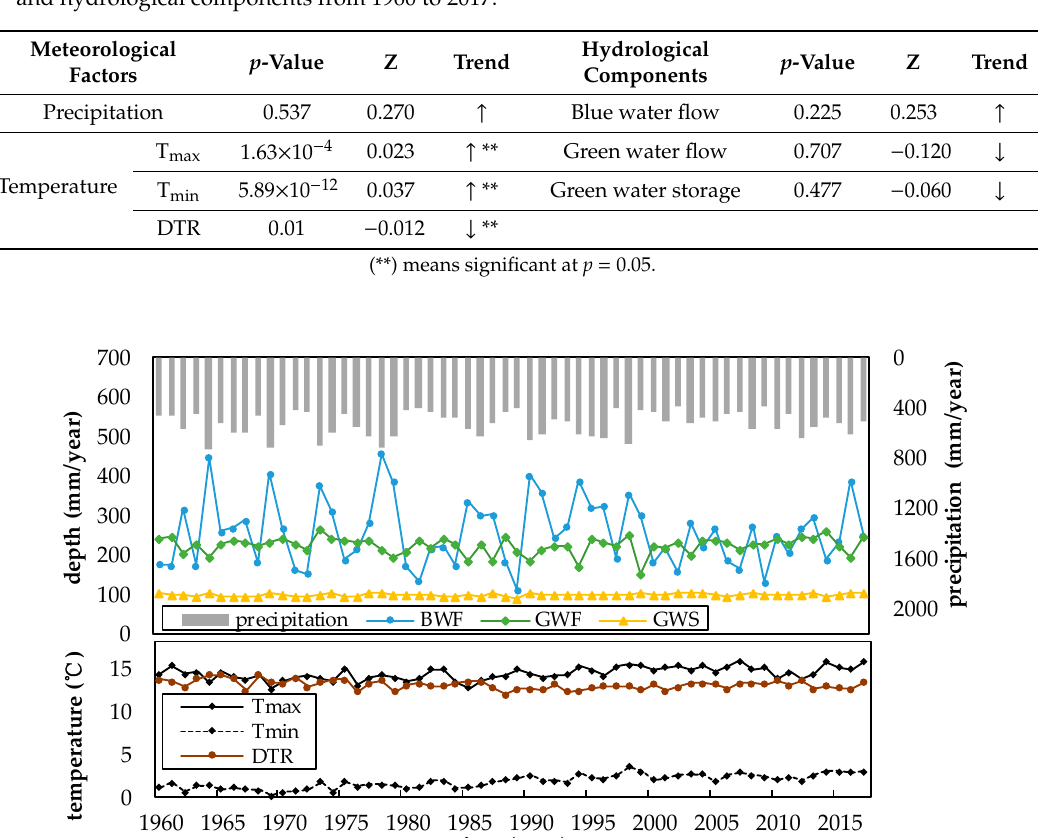
Table 3. The result of Mann–Kendall (MK) test for annual variability of meteorological factors and hydrological components from 1960 to 2017.